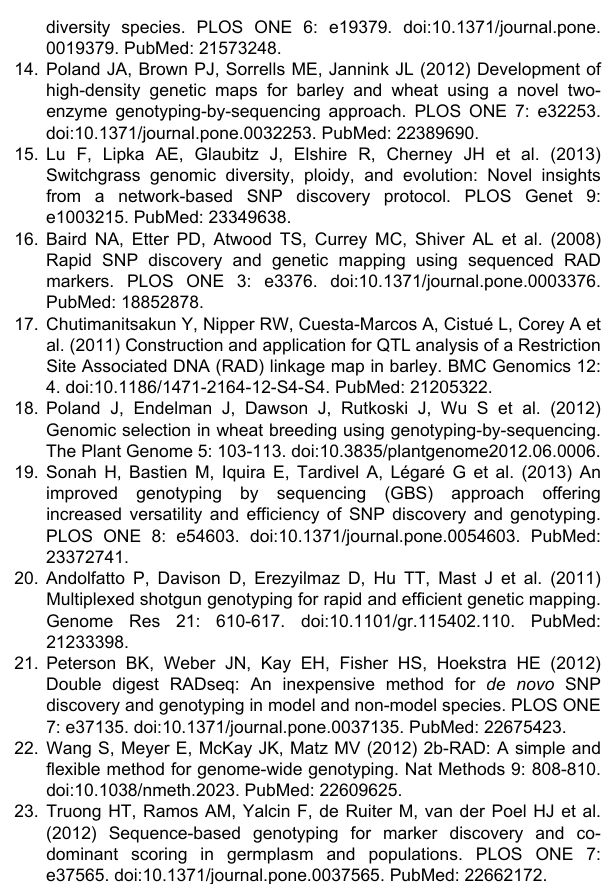
Table S3. Sequencing runs and sample bar codes. (TXT) Text S1. Protocol for genotyping-by-sequencing library construction for Ion